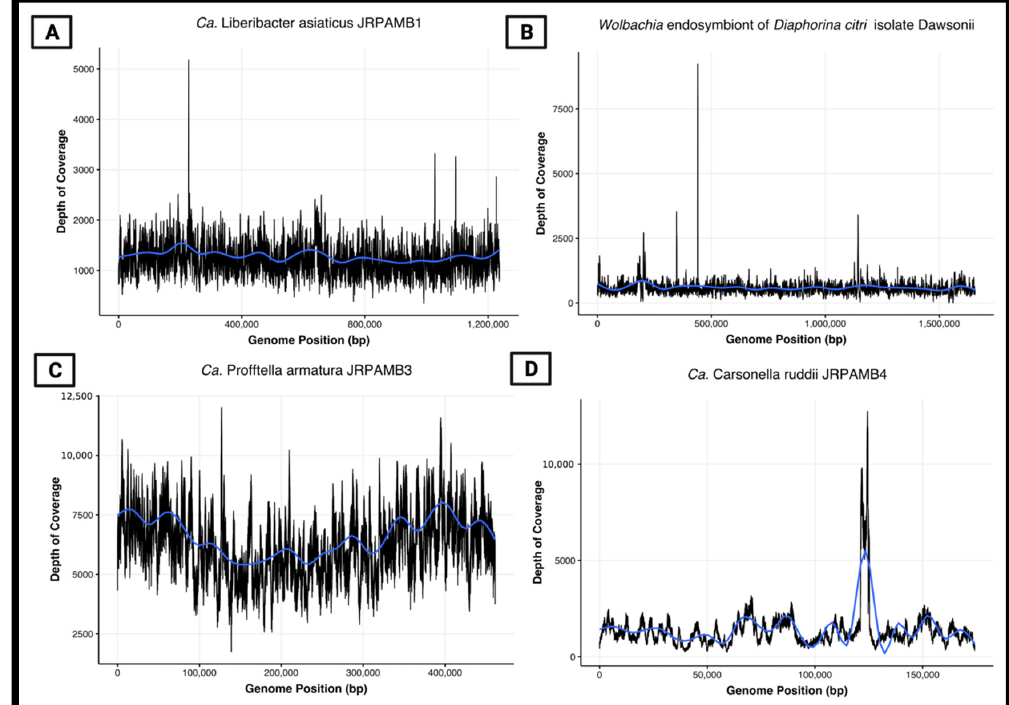
Figure 4. Depth of coverage vs. position of mapping to reference genome. Plots were generated in RStudio by mapping the PacBio run data to this publication’s submitted consensus genomes as reference using minimap2. The blue line represents the geom_smooth of RStudio ggplot regression averages. The x-axis refers to the nucleotide base pair position (bp) position of the genome from the start of the file. ( A ) Ca . L. asiaticus str. JRPAMB1. ( B ) Wolbachia str. dawsonii. ( C ) Ca. P. armatura str. JRPAMB3. ( D ) Ca . C. ruddii str.